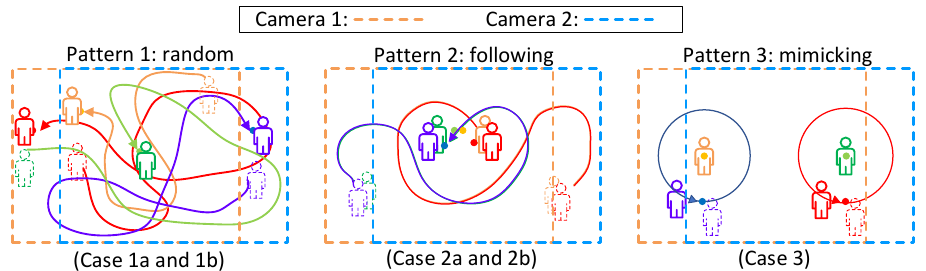
Figure 8. ( a ) Experiment scene. ( b ) Smartphone setup on chest.